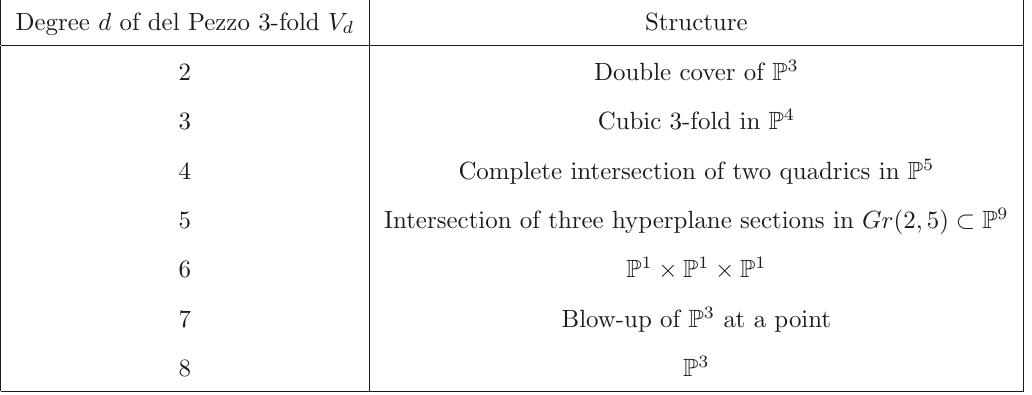
Table 1 . List of del Pezzo 3-folds with degree d , d = 2 , · · · , 8 [54–56]. Gr (2 , 5) denotes the complex Grassmannian of two-dimensional linear subspaces in C 5 . Gr (2 , 5) is embedded inside P 9 using the Pl¨ucker embedding; the restriction of a hyperplane section in P 9 to Gr (2 , 5) gives a hyperplane section of Gr (2 , 5). The del Pezzo 3-fold of degree 8 V 8 is the image of P 3 embedded in P 9 under the Veronese